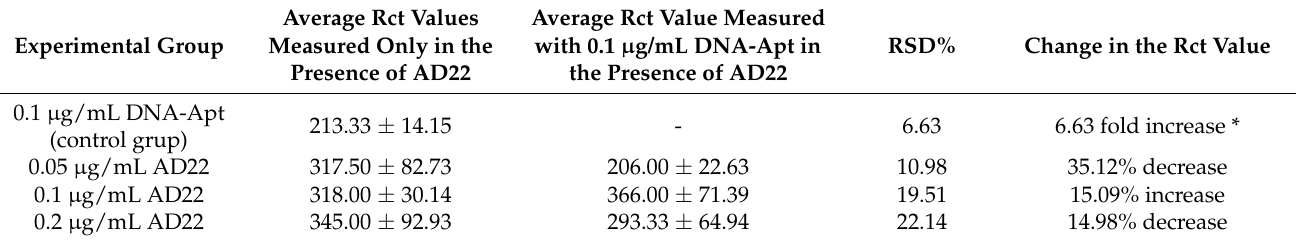
Table 1. The results obtained in the absence/presence of interaction DNA-Apt in different concentra- tions of AD22 with average Rct values ( n = 3) and